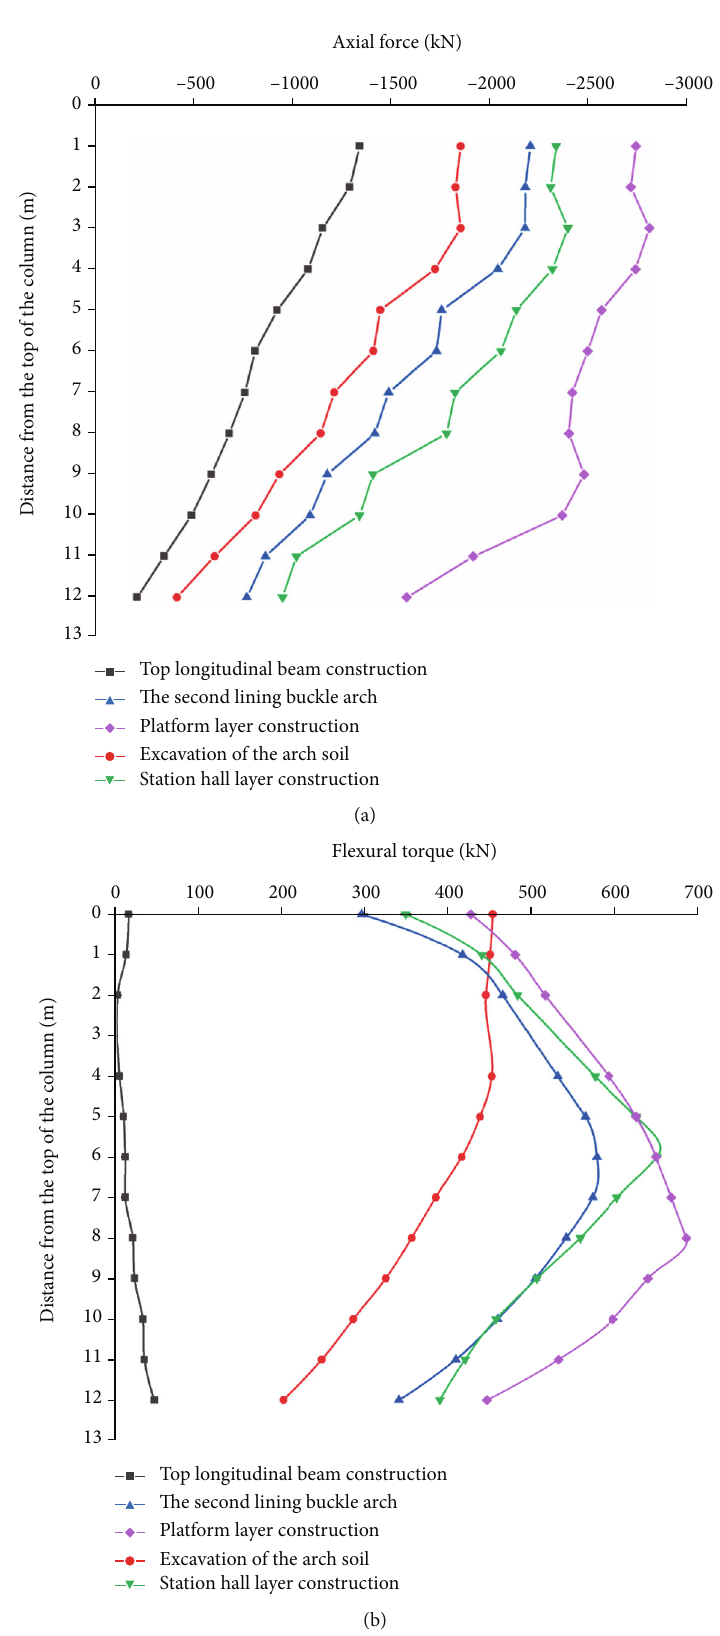
Figure 9: Distribution of the internal force of side piles from top to bottom in di ff erent construction stages. (a) Distribution of the axial force. (b) Distribution of fl exural